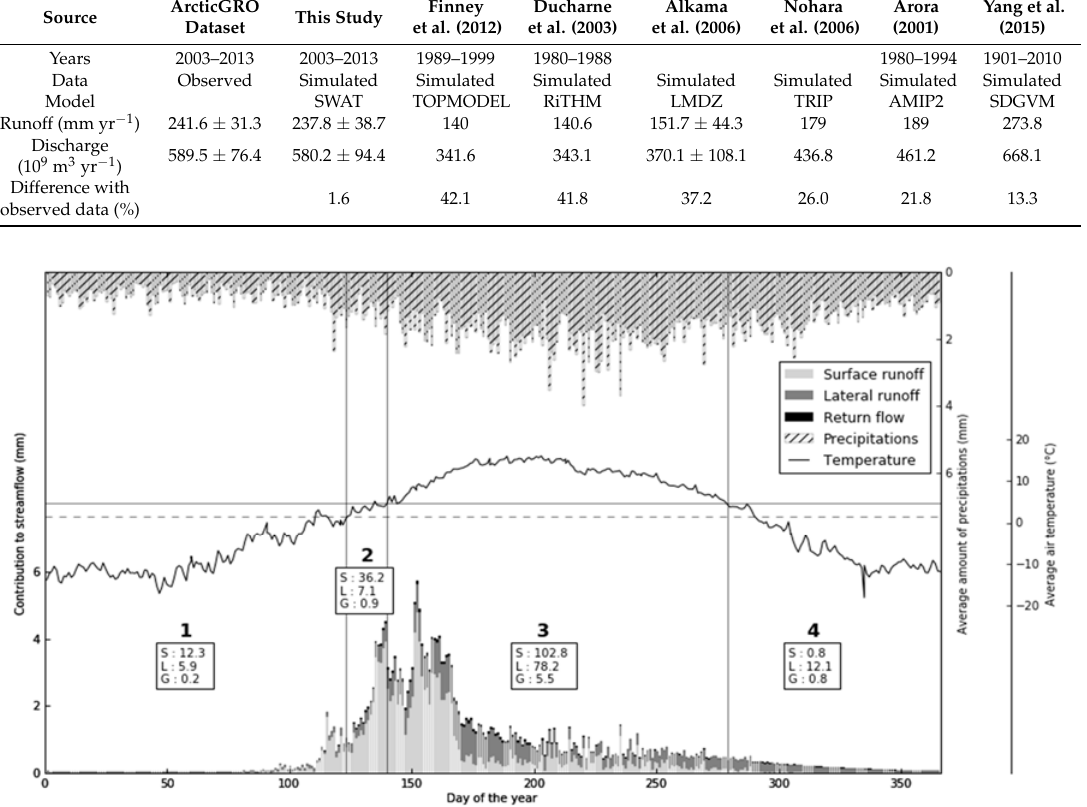
Figure 3. Interannual spatial average contribution to the streamflow per day for all the HRUs. We highlight 4 periods with 4 different hydrological behaviors corresponding to the conceptual model described in Materials and methods. In the boxes are noted the accumulated contribution on each period for surface runoff (S), lateral runoff (L) and groundwater (G). The average amount of precipitations per day and the average air temperature in the whole basin are also represented. The horizontal lines correspond to the modeled limits of snowfall (dashed line, 1.52 ◦ C) and snowmelt (solid line, 4.75 ◦ C) temperature (see Table 2). The vertical lines which separates the periods represents the date when temperature reaches the limits defined.